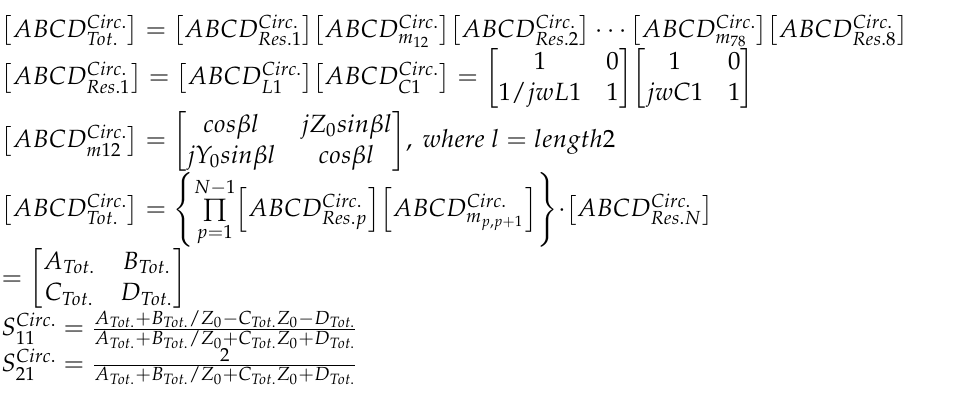
Table 2. Calculated unknowns of Figures 1 and 2 for the required BPF.